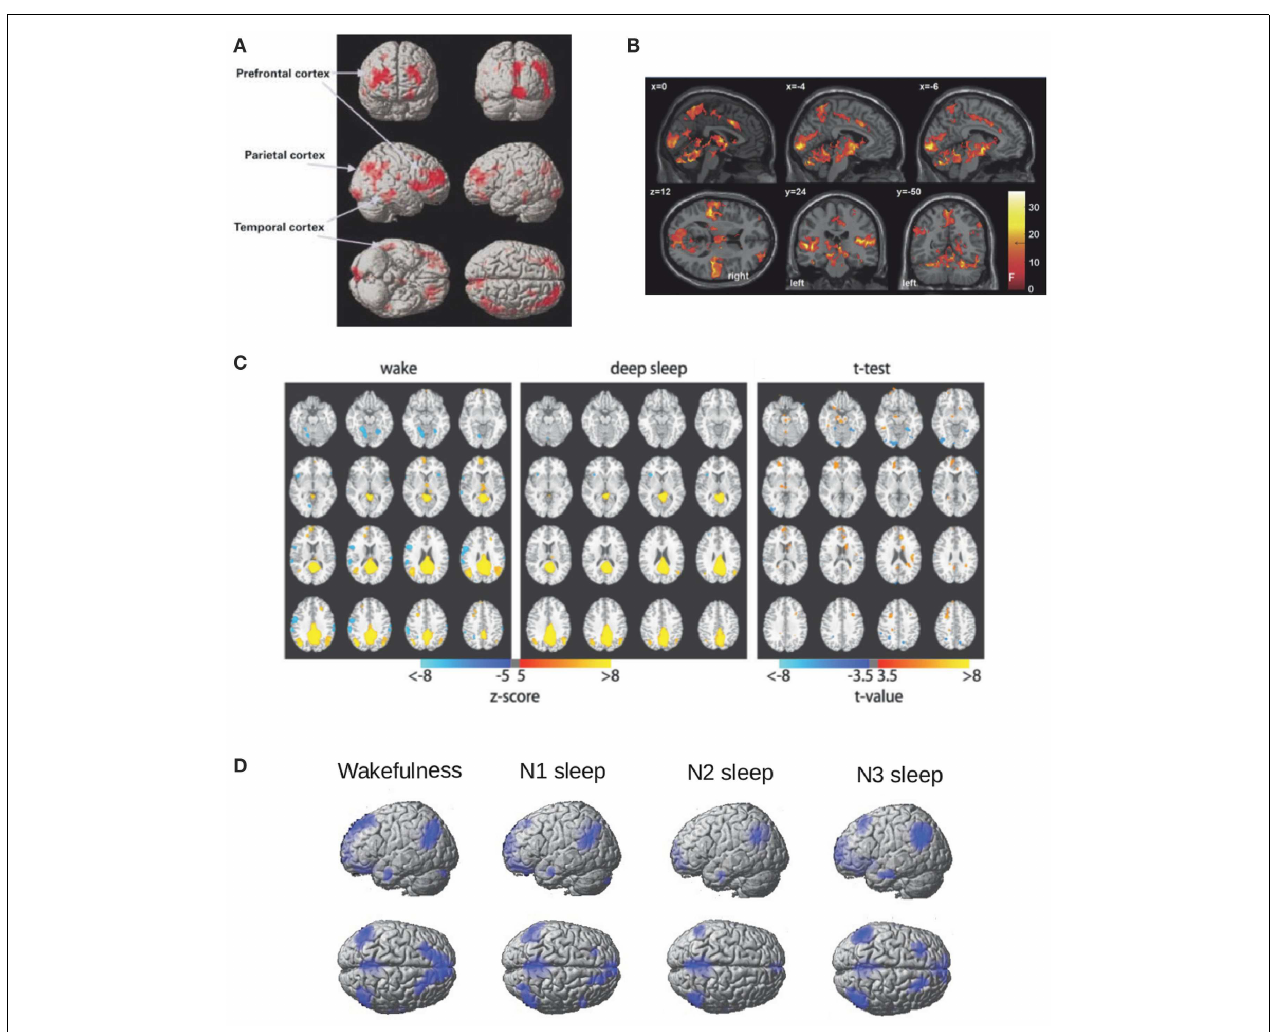
p < 0.05, FWE corrected. Figure reproduced with permission from Elsevier. (C) Seed correlation maps based on PCC during wakefulness and deep sleep ( z > 5) and for their difference ( z > 3.5) adapted from Horovitz et al. (2009). (D) The Default Mode Network (DMN) obtained with Independent Component Analysis (ICA) for wakefulness, N1, N2, and N3 sleep (the fMRI data used was previously reported inTagliazucchi et al.,